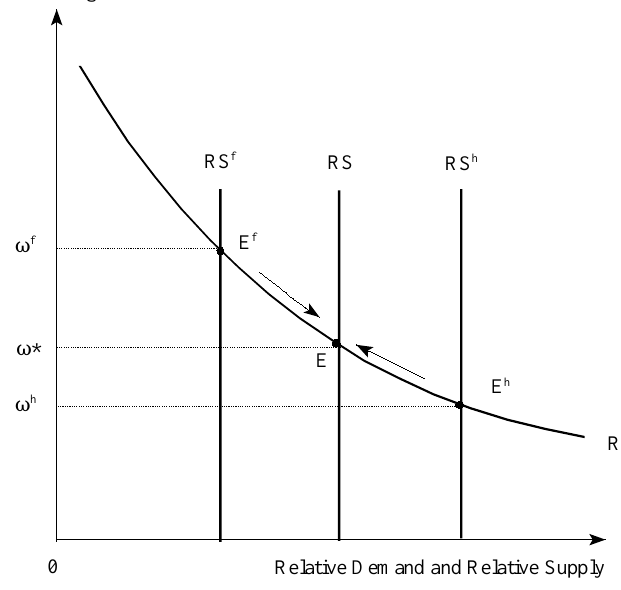
Figure 2. Trade and Relative